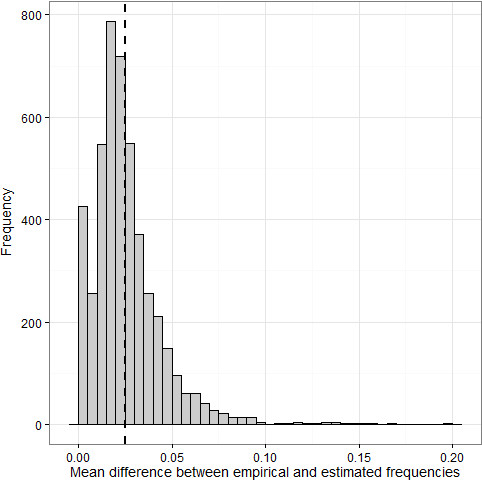
Histogram of the mean difference between the empirical and estimated allele frequencies for each locus. The vertical dotted line indicates the mean of the distribution (0.0253).